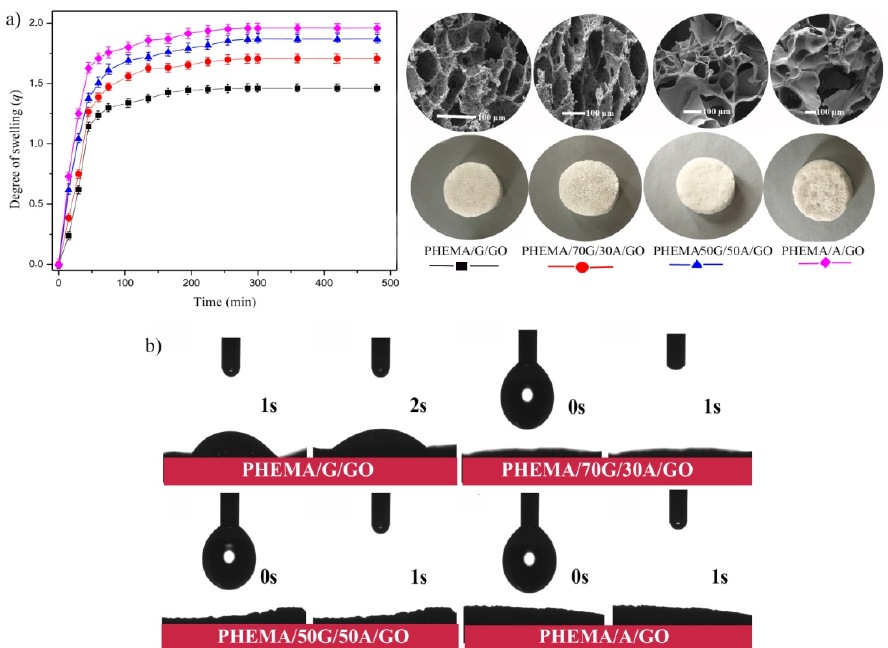
Figure 2. Values of: ( a ) degree of swelling of PHEMA/G/GO, PHEMA/70G/30A/GO, PHEMA50G/50A/GO and PHEMA/A/GO samples (average values from triplicate measurements) versus time; ( b ) water surface contact angle measurements of hydrogels.